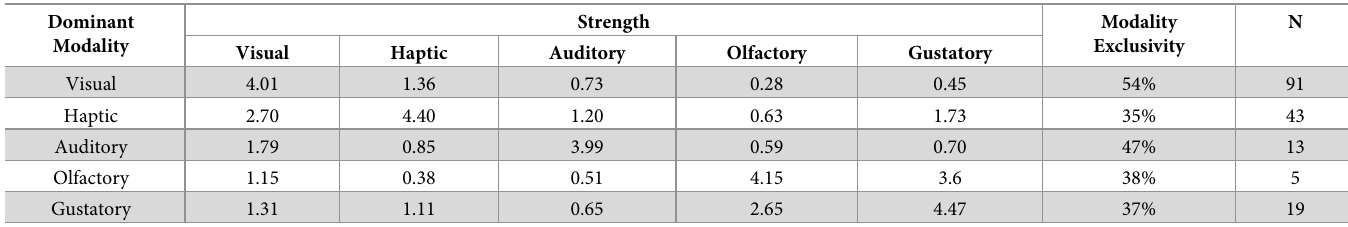
Table 2. Mean strength rating (0–5) on the five modalities, modality exclusivity scores, and number of the monosyllabic words per dominant modality. Dominant